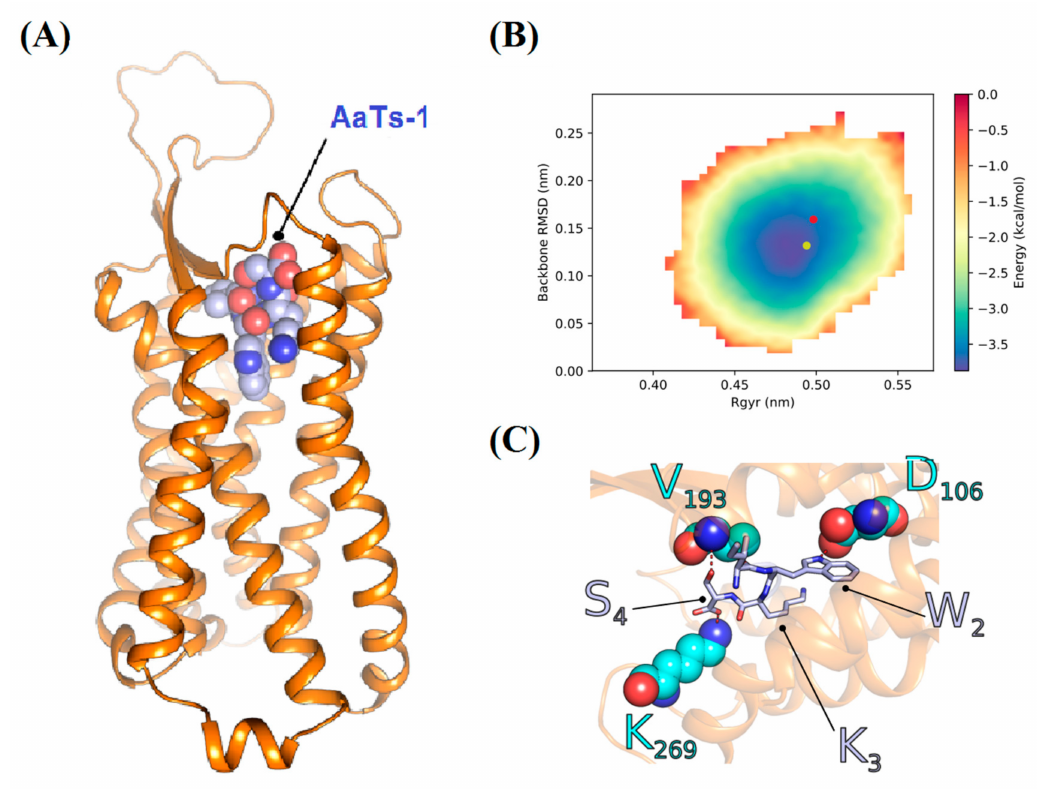
Figure 8. Computational analysis of the interaction of AaTs-1 peptide with FPRL-1. ( A ) Best complex according to the Rosetta score energy describing the interaction of AaTs-1 with FPRL-1. ( B ) Free energy landscape of AaTs-1 calculated from an ensemble of conformations generated with Monte Carlo simulation. The position of the docking conformation and the local minima are marked in red and yellow dots, respectively. ( C ) Polar interactions established between the residues of AaTs-1 and the residues of